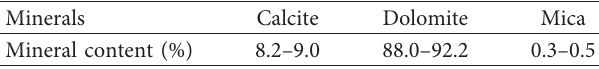
Table 1: Mineralogical composition of Jinping T